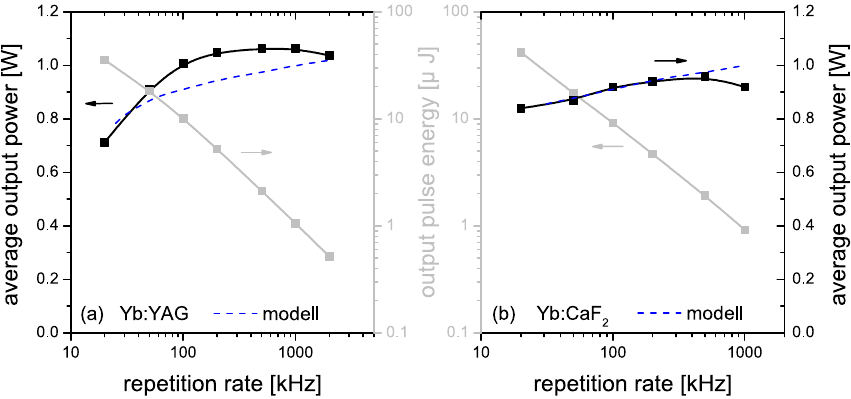
Figure 5. Average output power and pulse energy vs. repetition rate at regenerative amplification for Yb:YAG ( a ) and Yb:CaF